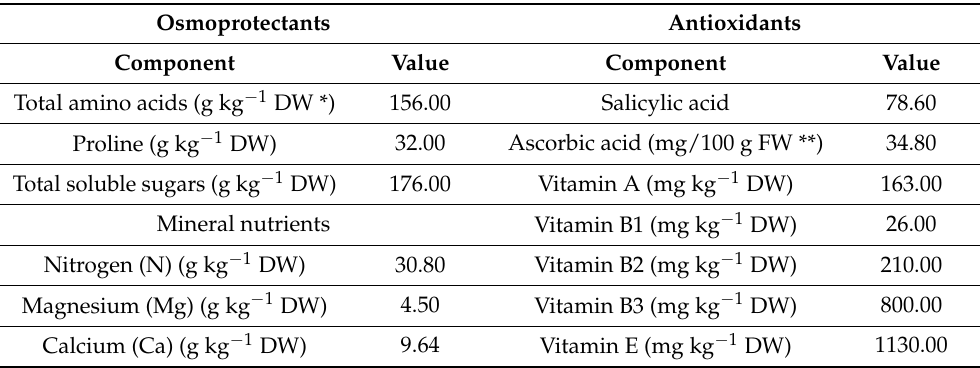
Table 2. Chemical components of watery moringa leaf extract